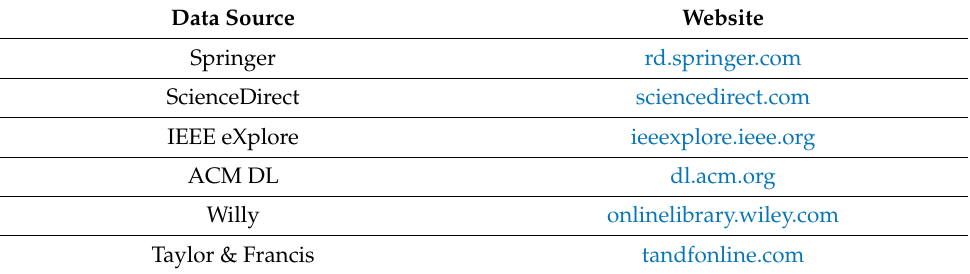
Table 4. The data sources used.